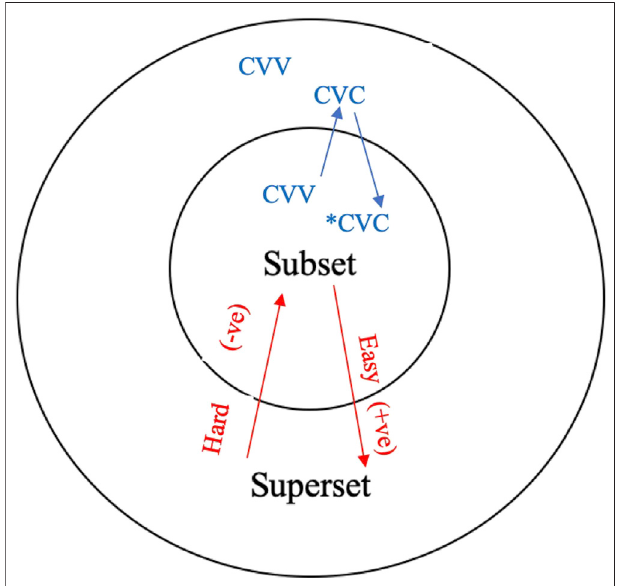
FIGURE 1 | The subset principle: positive (+ve) and negative ( − ve) evidence and ease or dif fi culty of learning illustrated by the quantity-sensitivity of Hungarian and English stress